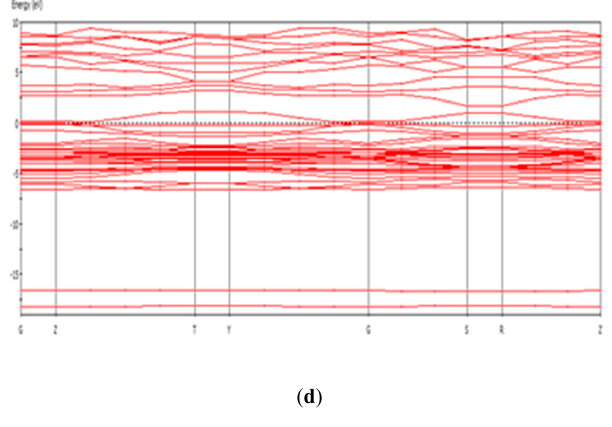
Figure 6. Band structure of ( a ) Fe 2 O 3 , ( b ) Fe 3 O 4 , ( c ) ZnO , ( d ) Al 2 O 3 , and ( e ) CNS.